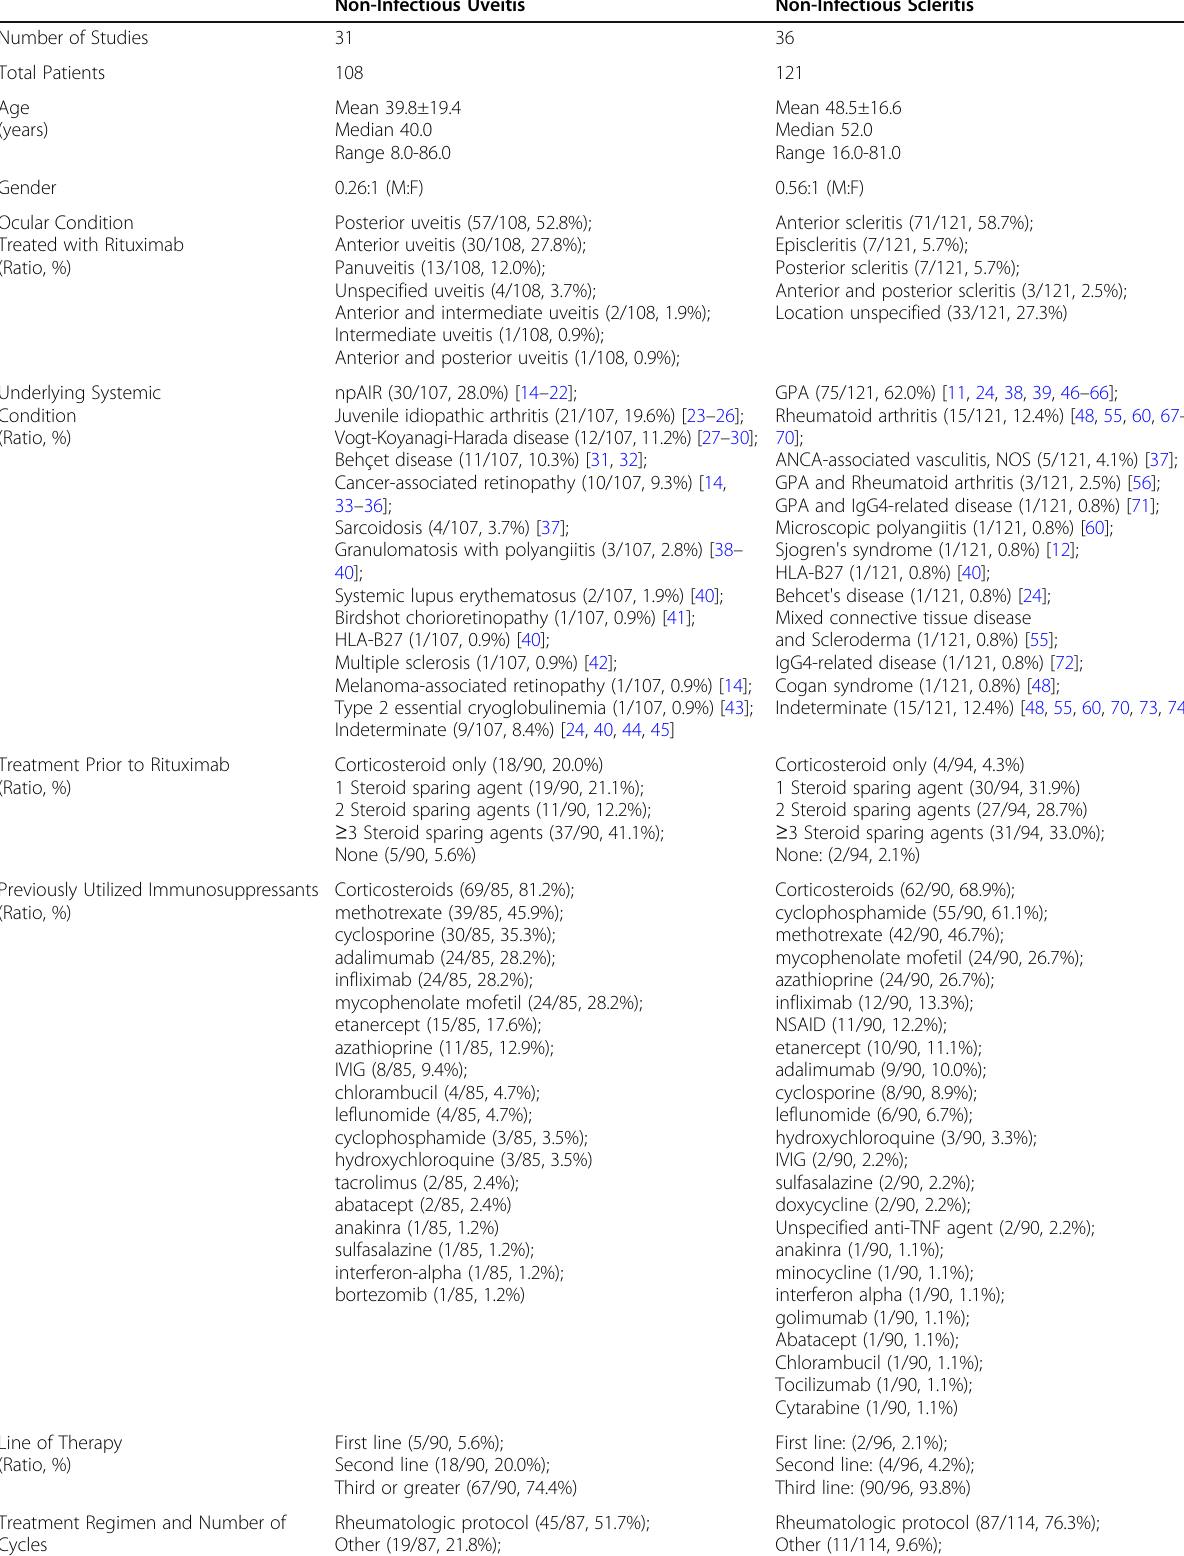
Table 1 Rituximab use in refractory non-infectious uveitis and scleritis - summary of comprehensive literature